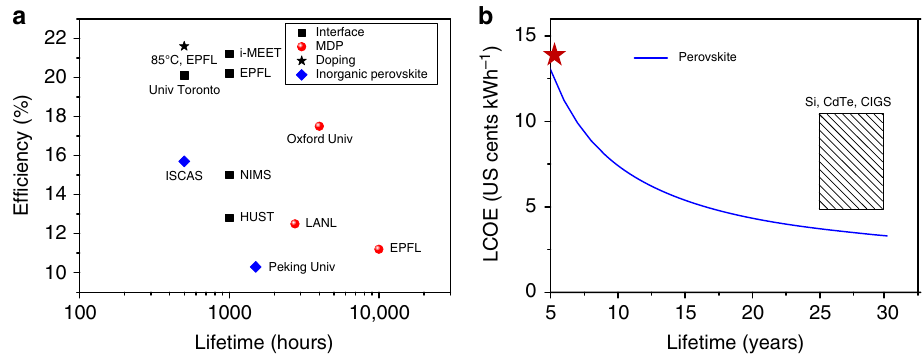
Fig. 2 Stability and Levelized cost of energy (LCOE) of perovskite photovoltaic. a The state art of power conversion ef fi ciency vs lifetime. Composition and interface engineering of perovskites have been adopted to improve the stability of perovskite solar cells. Interface: interface engineering including transport layer and electrode; MDP: multi-dimensional perovskite, Doping: inorganic cations doped in A site for ABX 3 structure; Inorganic perovskite: CsPbI 3 or CsPbBr 3 or their mixture. The 10,000 h stability reported from EPFL is T 100 stability, which means the device performance is not degraded during